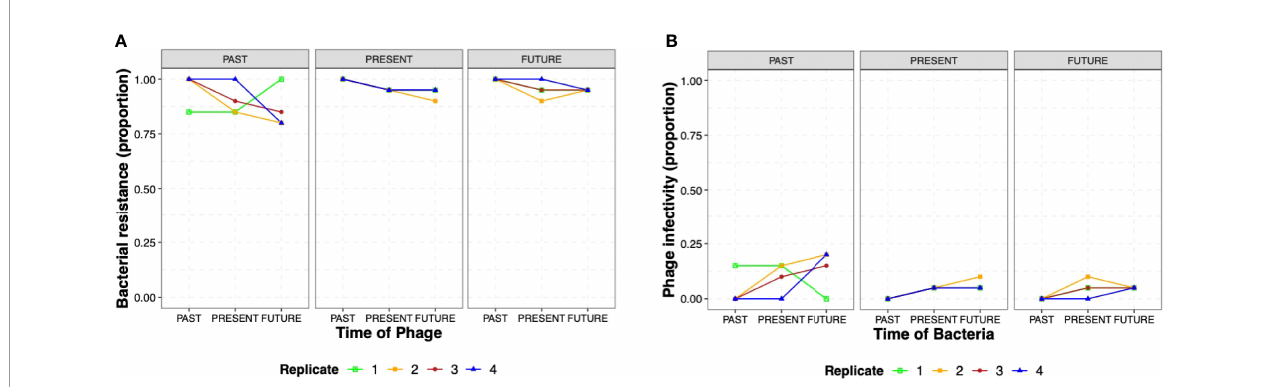
FIGURE 4 | Coevolutionary dynamics of S. Enteritidis and a lytic phage. (A) Proportions of the 20 colonies of S . Enteritidis that presented resistance to phage populations from i) the past (day 1), ii) the present (day 12), and iii) the future (day 21) for the four replicates (R1, R2, R3 and R4). (B) Proportions of phage infectivity, represented by lysis on the 20 isolated Salmonella from i) the past (day 1), ii) the present (day 12), and iii) the future (day 21) for the four replicates (R1, R2, R3 and R4). The fi gure does not show several times-points (past, present, and future) of replicates because proportions overlapped among replicates. Raw data of S . Enteritidis resistance and phage infectivity (proportion) are shown in Supplemental Tables 2, 3 ,